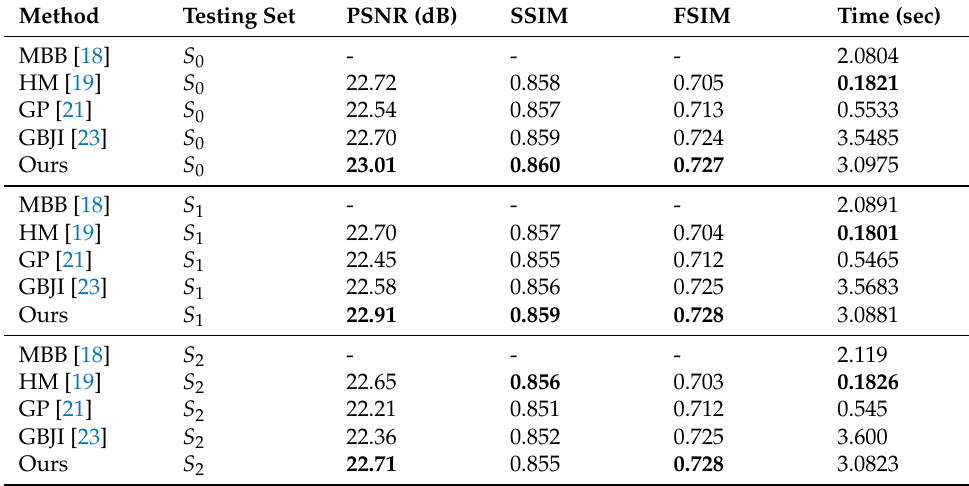
Table 1. The objective quality